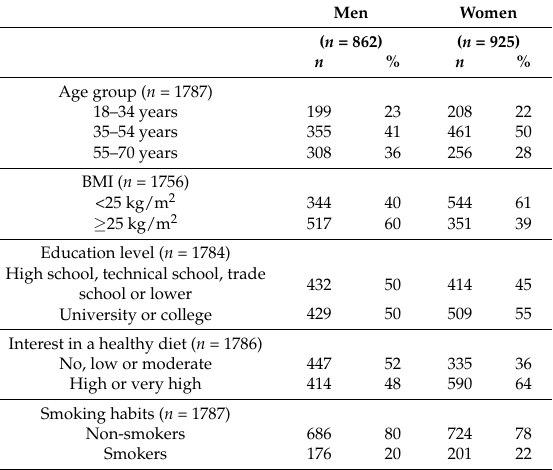
Table 1. Background characteristics of the study population in Norkost 3 ( n =